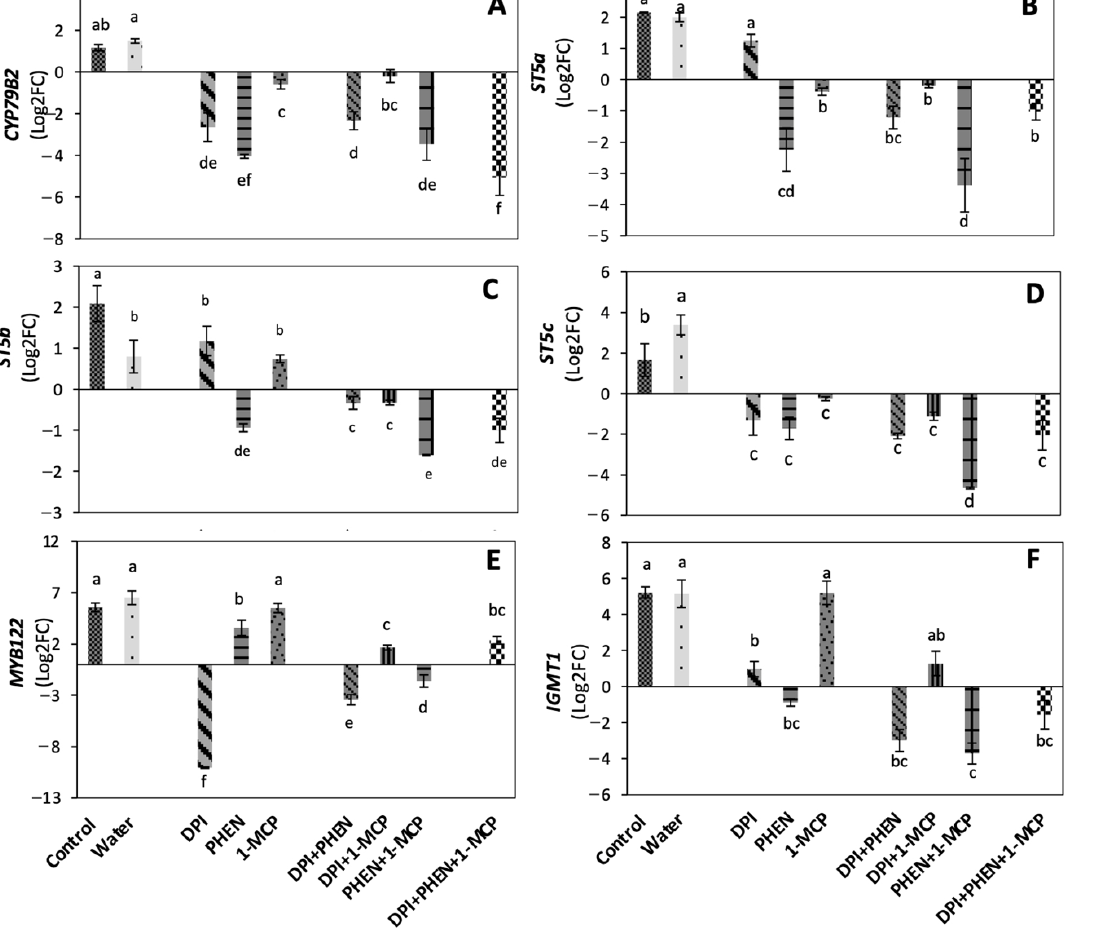
Figure 1. Effect of stress-signaling molecule inhibitors on the relative expression of glucosinolate biosynthetic genes. CYP79B2 ( A ); ST5a ( B ); ST5b ( C ); ST5c ( D ); MYB122 ( E ); IGMT1 ( F ). Relative expression is shown at 9 h after wounding. Expression was normalized with the house-keeping gene actin 2 and relative to time 0 h samples. Values represent the mean of three replicates ± standard error of the mean. Bars with different letters (a, b, c, d, e, and f) indicate significant difference by the LSD test ( p < 0.05). Abbreviations: diphenyleneiodonium chloride (DPI), phenidone (PHEN), 1-methylcyclopropene (1-MCP), cytochrome P450 gene ( CYP79B2 ), sulfotransferase a ( STSa ), sulfotransferase b ( STSb ), sulfotransferase c ( STSc ), MYB transcription factor gene ( MYB122 ), indole glucosinolate O-methyltransferase 1 ( IGMT1 ).